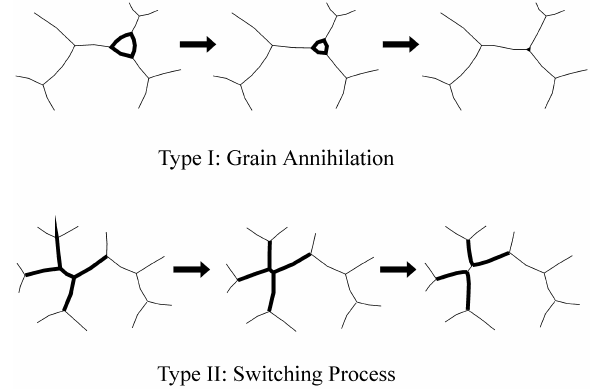
Figure 15. Illustraiting the progress in terms of the evolution of the pore and grain boundary structures associated with a